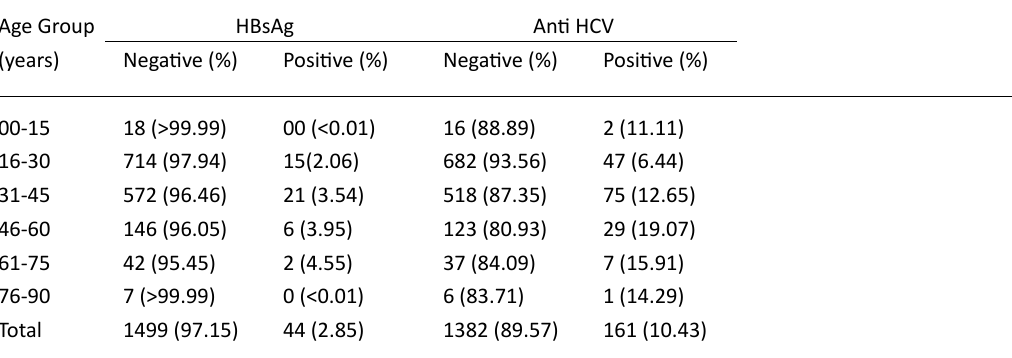
Table 3. Observed Frequencies of patients in different age groups.